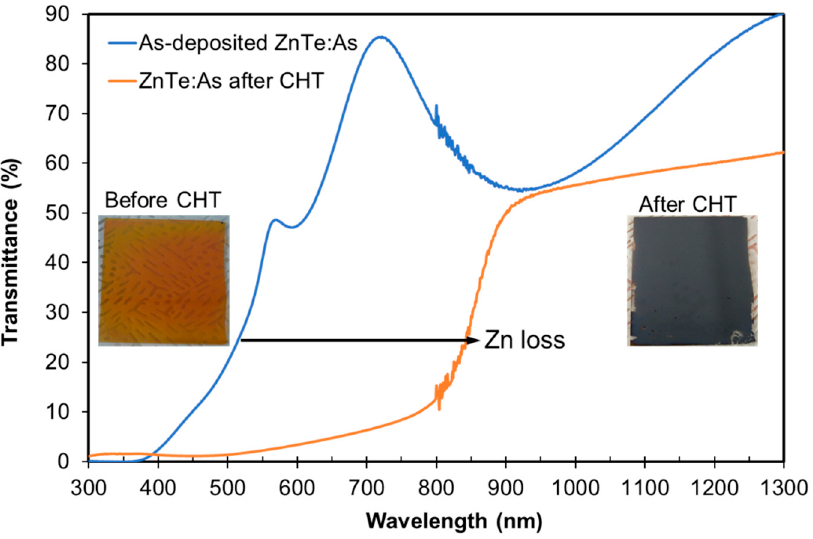
Figure 6. Transmittance spectra and image of a reference thin film of ZnTe:As before and after the standard CHT.